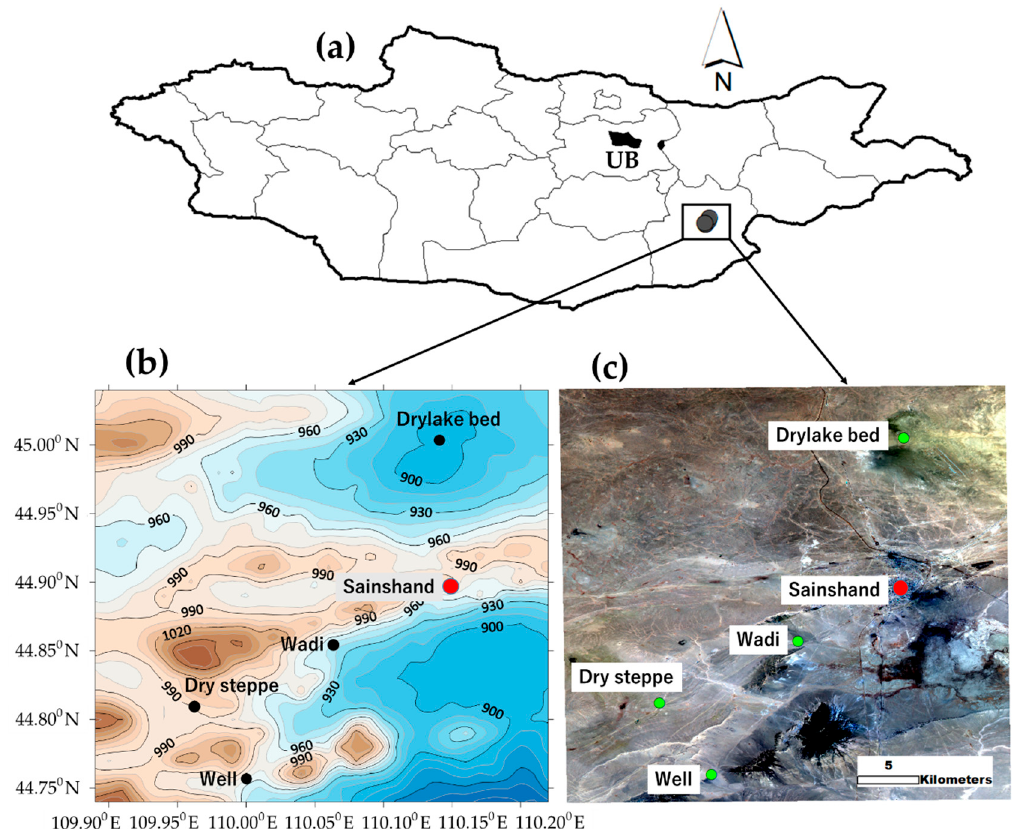
Figure 1. The study points are shown on the map, where ( a ) indicates the location in Mongolia, and ( b ) indicates the four research survey points. The vertical axis shows latitude, the horizontal axis shows longitude, and the numbers show the altitude; ( c ) the study points in Sentinel 2 image.